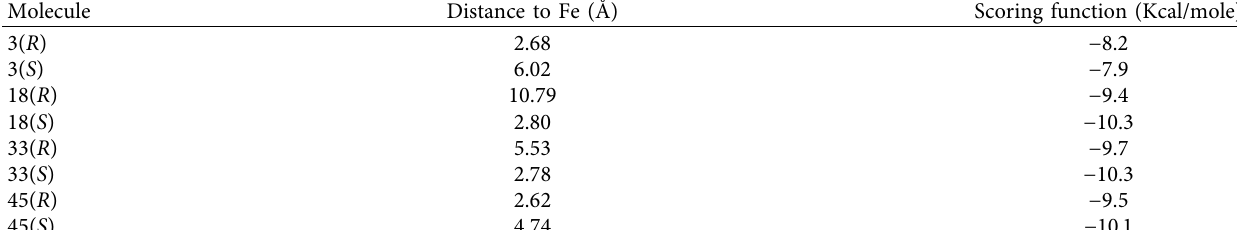
Table 11: Distance to Fe and scoring function values.